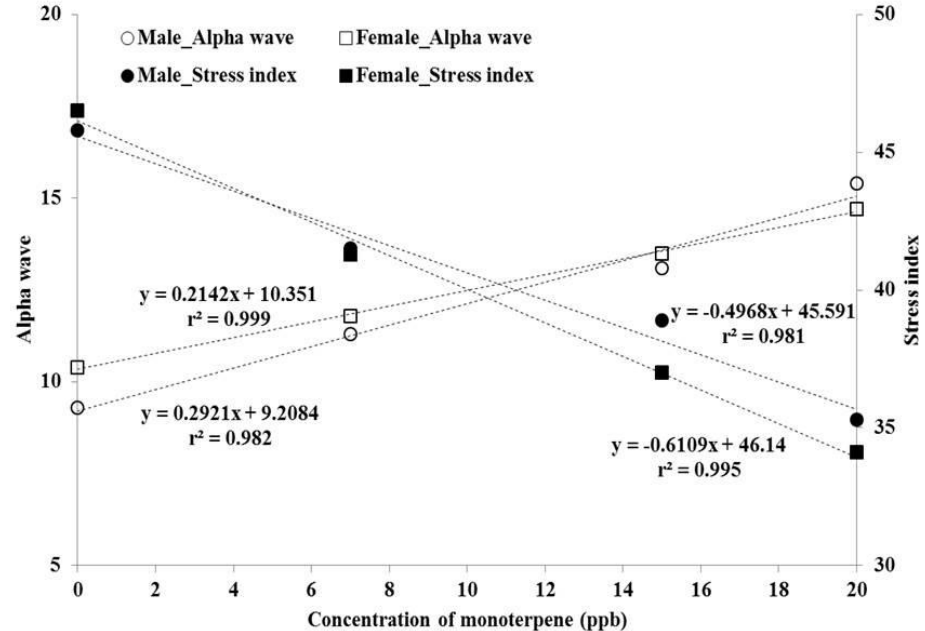
Figure 4. Variations of the mean values of alpha waves and stress index of 30 participants with respect to the concentration of MTs, as obtained from Exp 2.